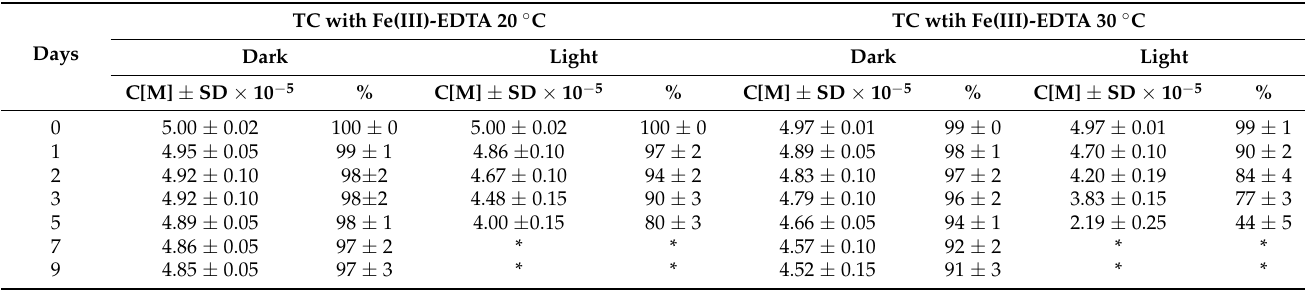
Table 1. Tetracycline concentrations [M] and percent ratios of TC concentrations in samples treated with Fe(III)-EDTA relative to controls for incubations at darkness and light, at 20 ◦ C and 30 ◦ C.